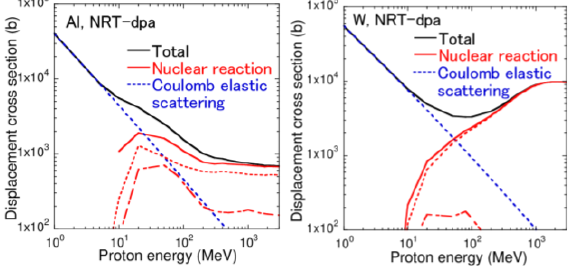
Figure 1 . NRT-dpa cross sections for proton irradiation on aluminium and tungsten.